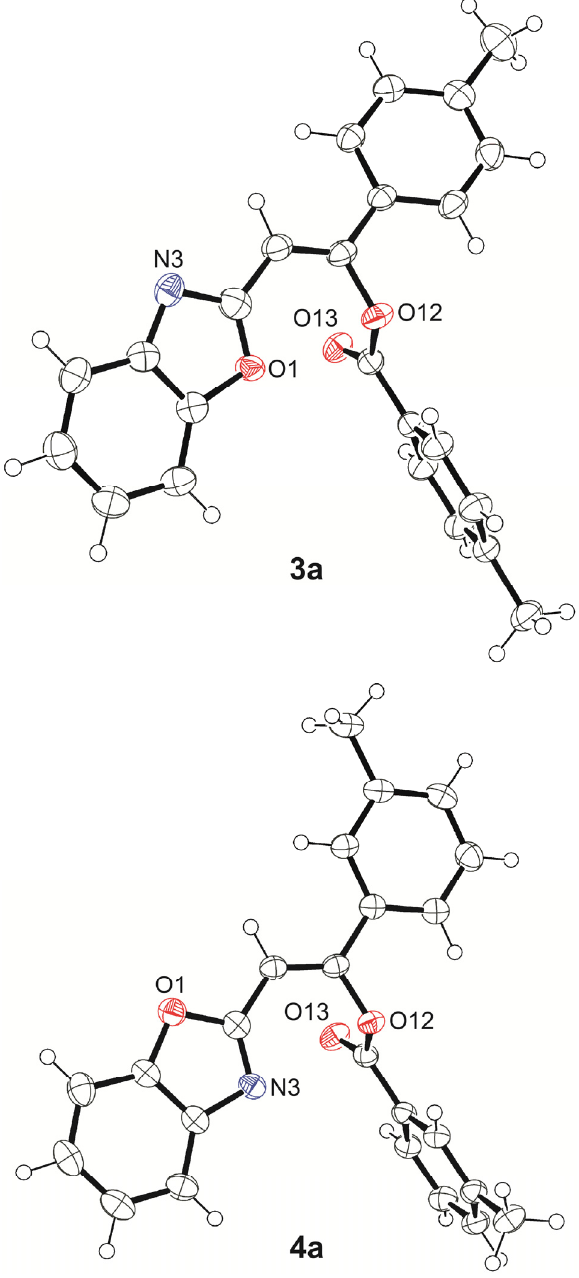
Figure 1. Single crystal thermal ellipsoid structures (ORTEP plots) of 3a and 4a . The positional disorders in methyl groups (H-atoms) and in benzoxazole moiety of 3a were removed for